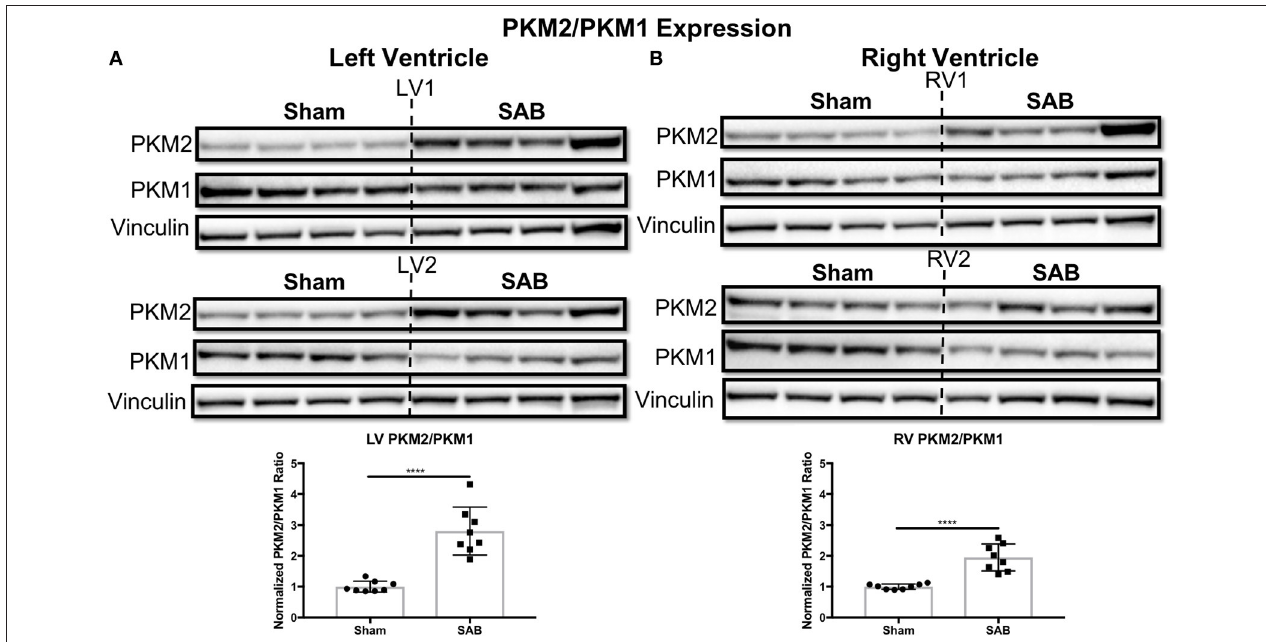
FIGURE 7 | Pyruvate kinase muscle (PKM) isoform 2 to 1 ratio is increased in supra-coronary aortic banding (SAB) vs. sham rats. Western blot showing upregulation of PKM2 and downregulation of PKM1, thus resulting in significant increase of PKM2/PKM1 ratio in the (A) left ventricle (LV) and (B) right ventricle (RV) of supra-coronary aortic banding (SAB) rats vs. sham rats. Each band represents a unique animal. Two experimental cohorts were done; hence two groups are shown, labeled as 1 and 2. The same vinculin loading control is used for proteins probed on the same